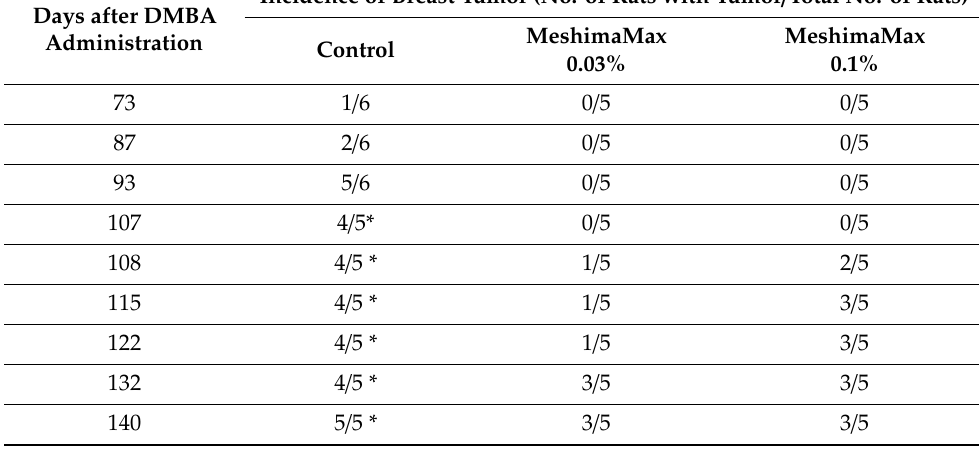
Table 1. Incidence of breast tumor in rats receiving 7,12-dimethylbenz anthracene (DMBA) in the presence / absence of